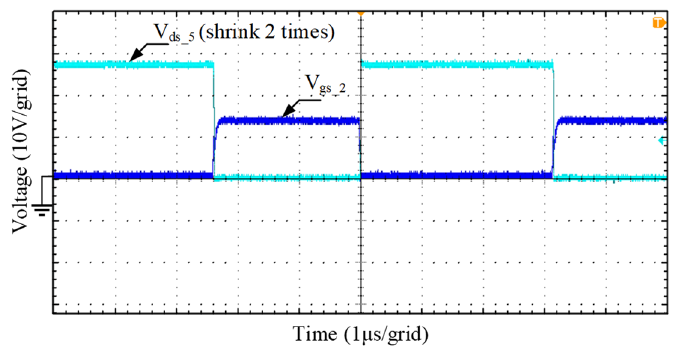
Figure 35. Switching transistor Q 5 zero voltage turn-on waveform.